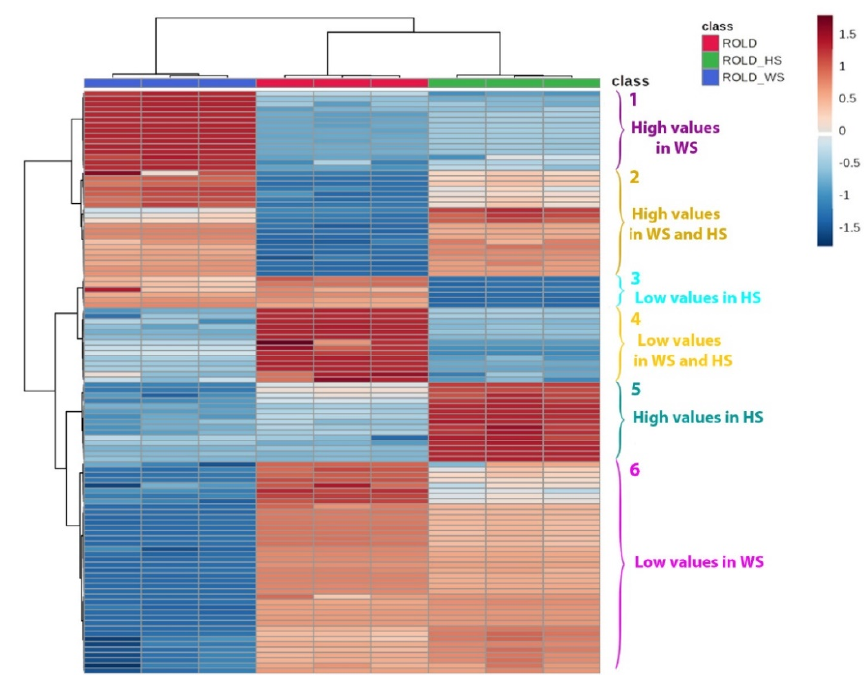
Figure 2. Heatmap of the main metabolites identified in Nicotiana langsdorffii RolD (red), RolDWS (blue), and RolDHS (green). The clusters indicate metabolites that showed different patterns in the three classes of samples. Cluster 1: compounds with high values in water stress (WS); Cluster 2: compounds with high values in WS and high temperature stress (HS); Cluster 3: compounds with low values in HS; Cluster 4: compounds with low values in HS and WS; Cluster 5: compounds with high values in HS; and Cluster 6: compounds with low values in WS.